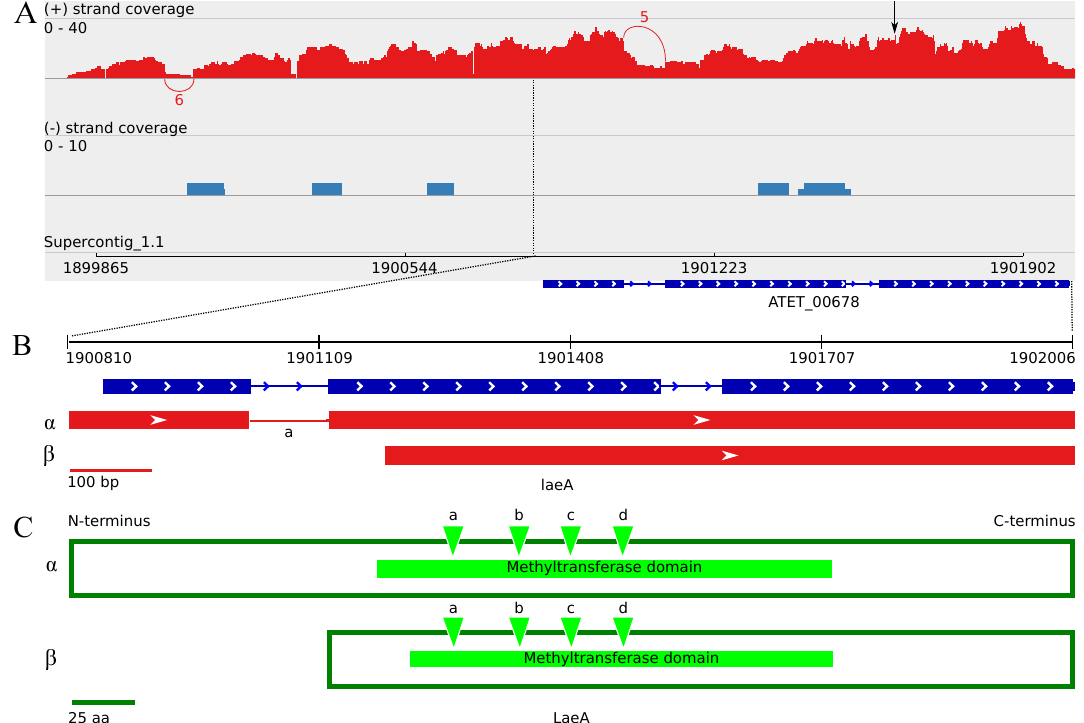
Figure 5. Splice variants and predicted protein domains of the regulative methyltransferase LaeA ortholog. Sashimi plot of ( A ) the laeA ortholog describing the strand-specific alignment coverage of the read sequences of A. terreus MUCL 38669 over the corresponding genomic region of supercontig _1.1 of NIH2624. The curved splice junctions represent the number of spliced reads indicating an intron at that specific location. The black arrow on top of the coverage profile indicates a 1-bp deletion at 1901621(+). ( B ) An enlarged figure of the ORF-level splice variants of the laeA ortholog as indicated by the Sashimi plot. The boxes represent the exons; the arrow heads indicate the strand of the transcript; and the lines represent introns. The apparent alternative splicing that leads to two different ORFs occurs at the second transcriptional intron (a). Approximately 36% of the covering reads support the occurrence of the intron, resulting in a laeA- α splice variant. Approximately 64% of the covering reads that support the absence of the intron result in a laeA- β variant. ( C ) A schematic description of the encoded protein variants ( α and β ) of the LaeA ortholog with the predicted methyltransferase domain (pfam13489). The triangles indicate the predicted SAM-binding sites (a: seven amino acid residues; b: 2 aa; c: 3 aa; d: 1